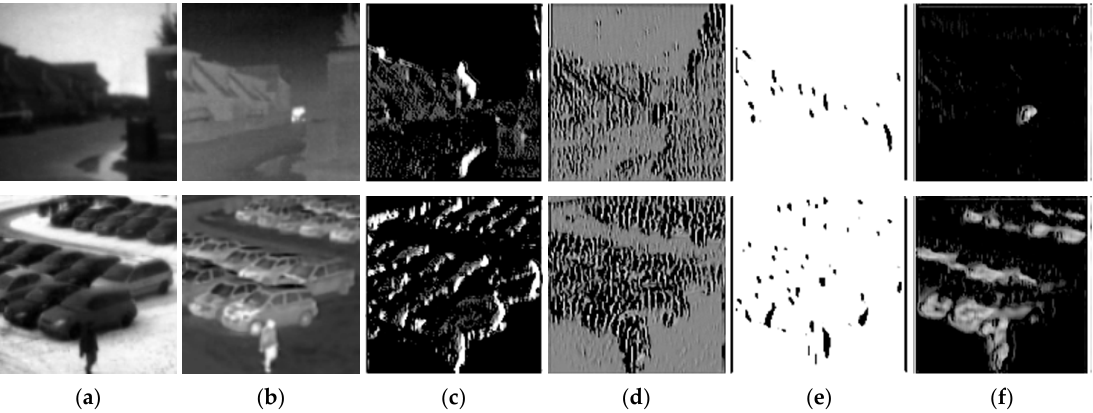
Figure 12. Comparison of feature map of feature extractor and mask predictor [15] and shallow feature extraction network. From left to right: ( a ) visible image patch, ( b ) infrared image patch, ( c ) visible fine-feature map in feature extractor and mask predictor [15], ( d ) infrared fine-feature map in feature extractor and mask predictor [15], ( e ) visible fine-feature map in shallow feature extraction network (proposed method), and ( f ) infrared fine-feature map in shallow feature extraction network (proposed method). Table 2. Comparison of corner error [31] of feature extractor and mask predictor [15] and shallow feature extraction network. Rows 2 and 3 represent the corner error [31] corresponding to the two sets of sample images in Figure 12, respectively. Column 2 represents the corner error [31] obtained by replacing the shallow feature extraction network with a feature extractor and mask predictor [15]. Column 3 represents the corner error [31] obtained using a shallow feature extraction